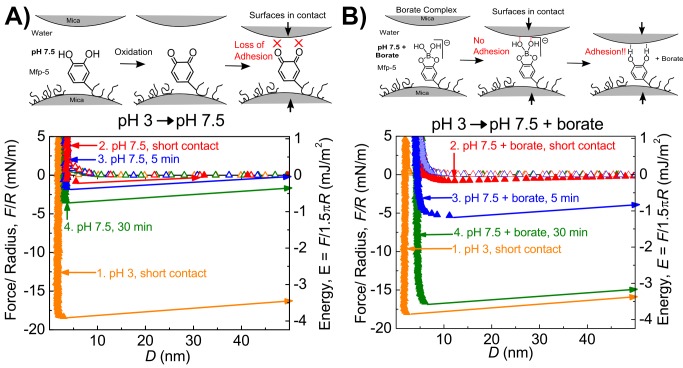
Adhesion of Mfp-5 to mica at pH 3 and pH 7.5 with and without borate.(A) Adhesion of Mfp-5 to mica at pH 3 (0.1 M HAc, 0.25 M KNO3) (run 1) in which buffer was increased to pH 7.5 (0.1 M Phosphate, 0.25 M KNO3) without borate (run 2–4). (B) Adhesion of Mfp-5 to mica at pH 3 was increased to pH 7.5 with borate (0.1 M). Boronate-complexed Mfp-5 retains nearly full adhesion. Note, overview of how to read SFA data is shown in Fig. S5. Open symbols represent the in-run.